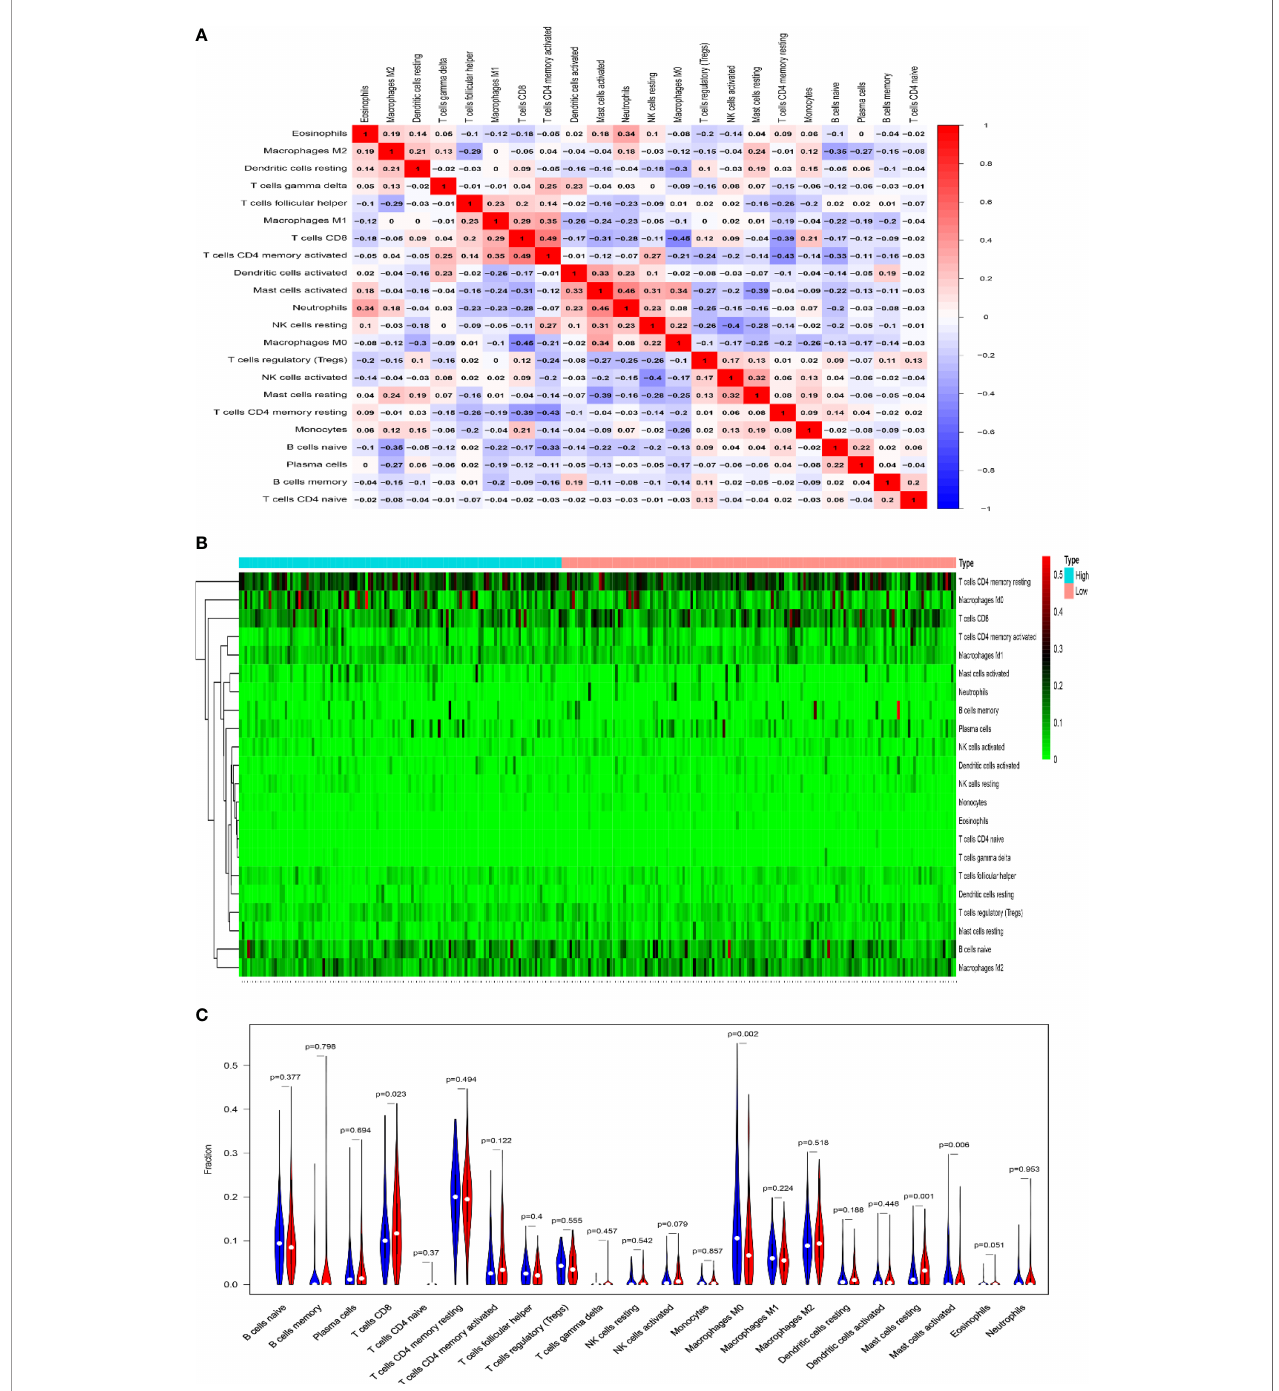
FIGURE 4 | Results of CIBERSORT analysis and immune in fi ltration between MAGEA3 high- and low-expression groups. (A) Correlation matrix of in fi ltration degree of immune cells in GC samples. Red indicates trends consistent with the positive correlation, and blue indicates trends consistent with the negative correlation between two immune cells. The bigger size of the number statistics data represents the more positive or negative correlation. (B) The distribution of 22 immune cells in 267 fi ltered gene matrix. Red indicates higher immune in fi ltration expression, and green indicates lower expression. (C) Violin diagram of immune cell proportions in two groups. The blue fusiform fractions on the left represent the MAGEA3 high-expression group, and the red fusiform fractions on the right represent the MAGEA3 low-expression